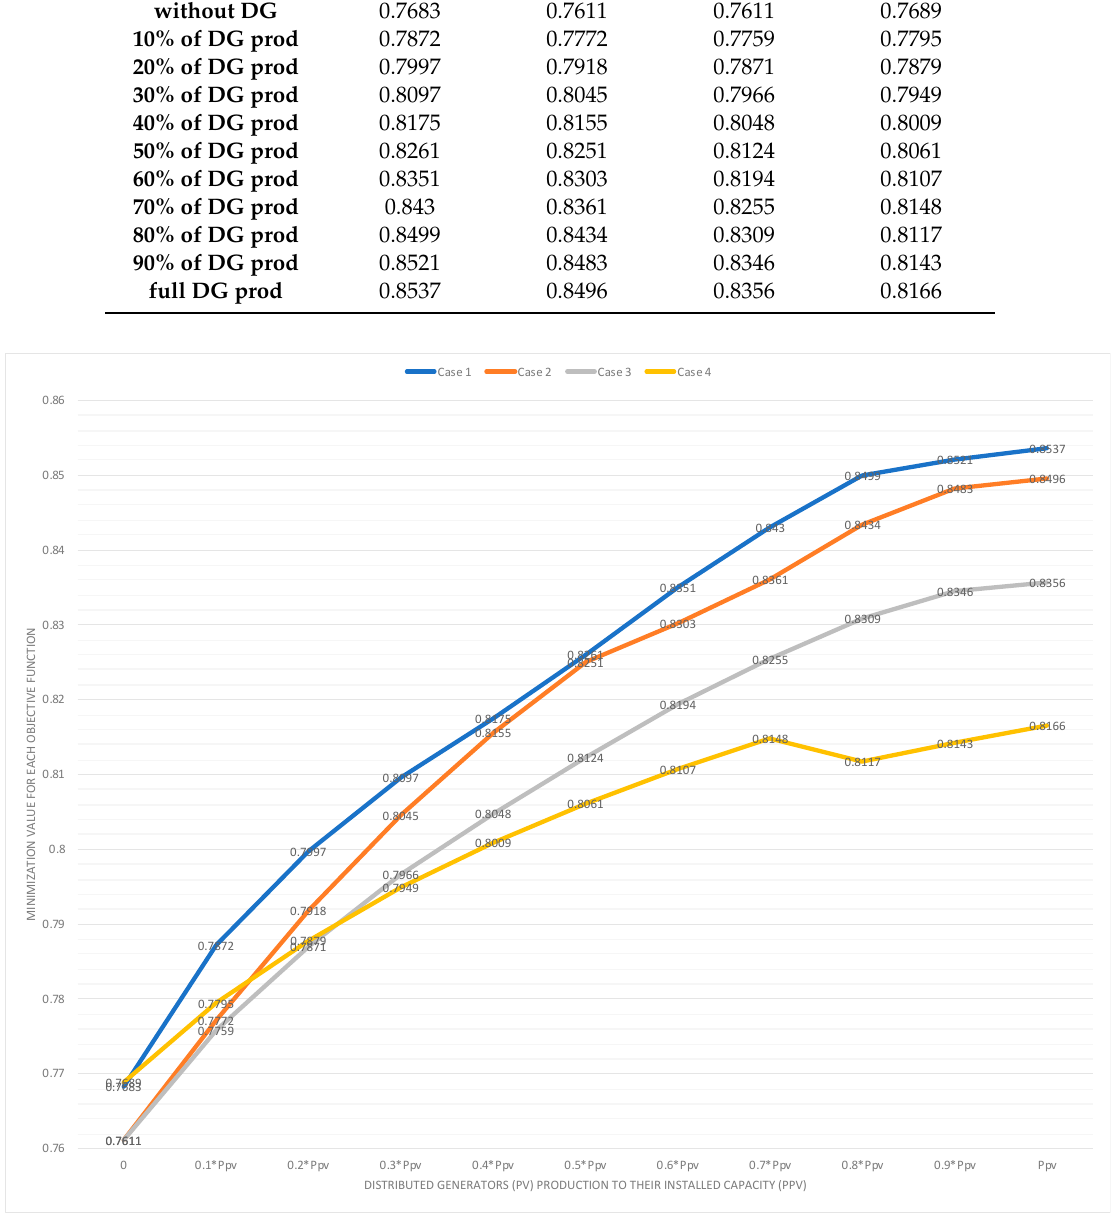
Figure 3. Graphical representation of the calculated values. Table 6. Loading per node for case 1.